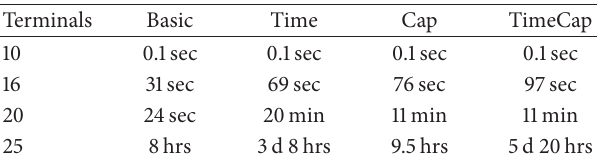
Table 1: Solution